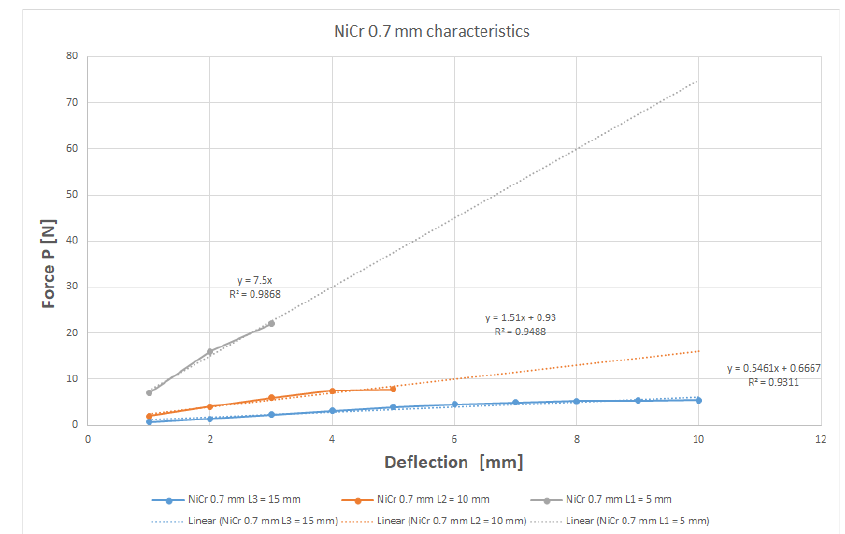
Figure 6. Graph that shows the linear regression for NiCr 0.7 mm. For wire of 0.7 mm diameter Ni-Cr, bent at an arm of 5, 10 and 15 mm, the corre- sponding deformations (in mm) are listed in Table 1.